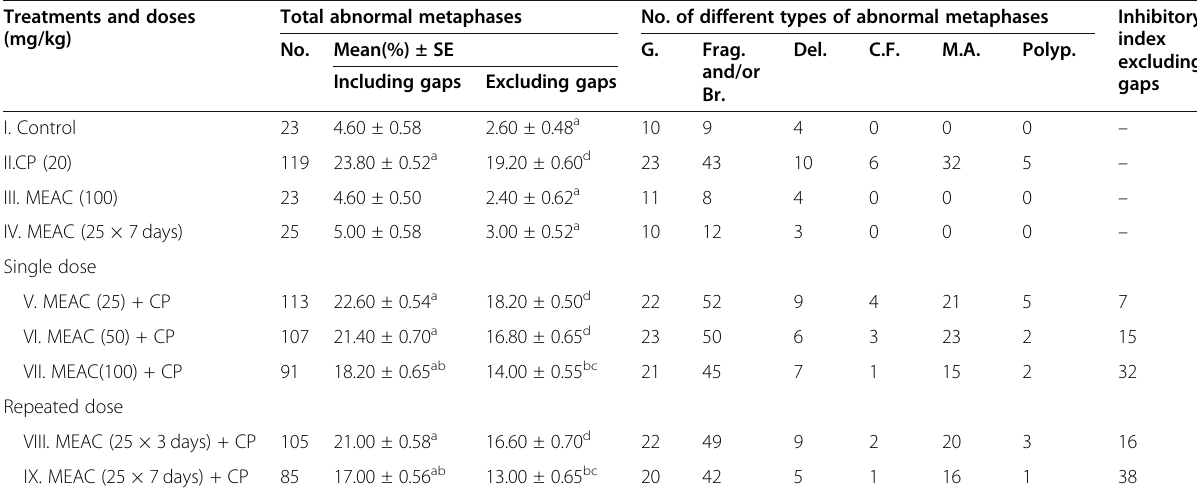
Table 1 Frequency of chromosomal abnormalities in mouse bone marrow induced after treatment with CP and MEAC Treatments and doses Total abnormal metaphases No. of different types of abnormal (mg/kg)